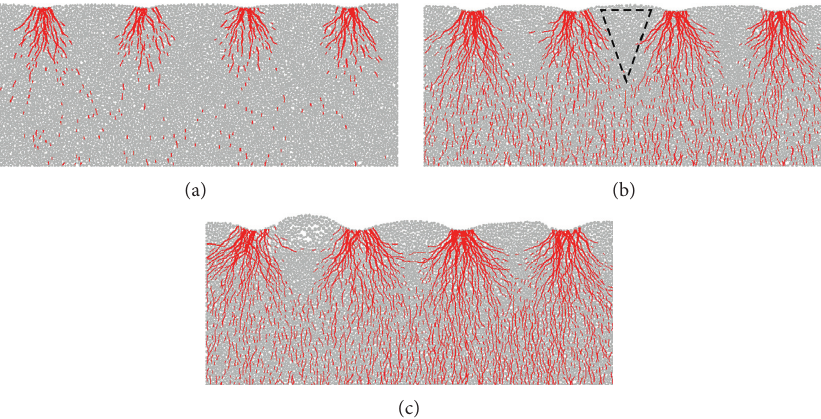
Figure 9: Intraparticle force chain distribution at different time steps. (a) Intraparticle force chain distribution at 2500 time steps. (b) Intraparticle force chain distribution at 5000 time steps. (c) Intraparticle force chain distribution at 10,000 time steps.